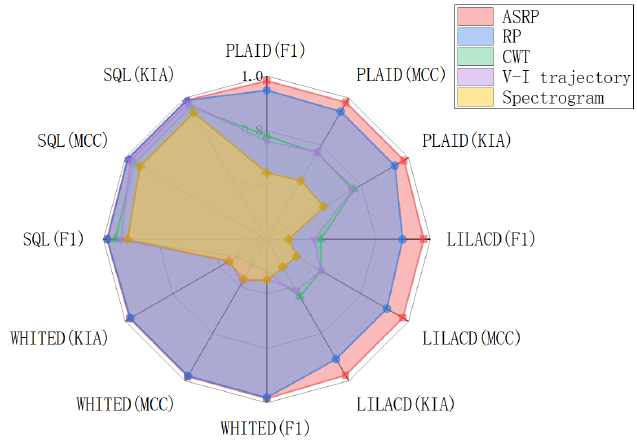
Figure 12. Comparison of the recognition results obtained by different load feature extraction methods for each dataset. Table 4. Comparison of recognition scores obtained with different load feature extraction methods for each